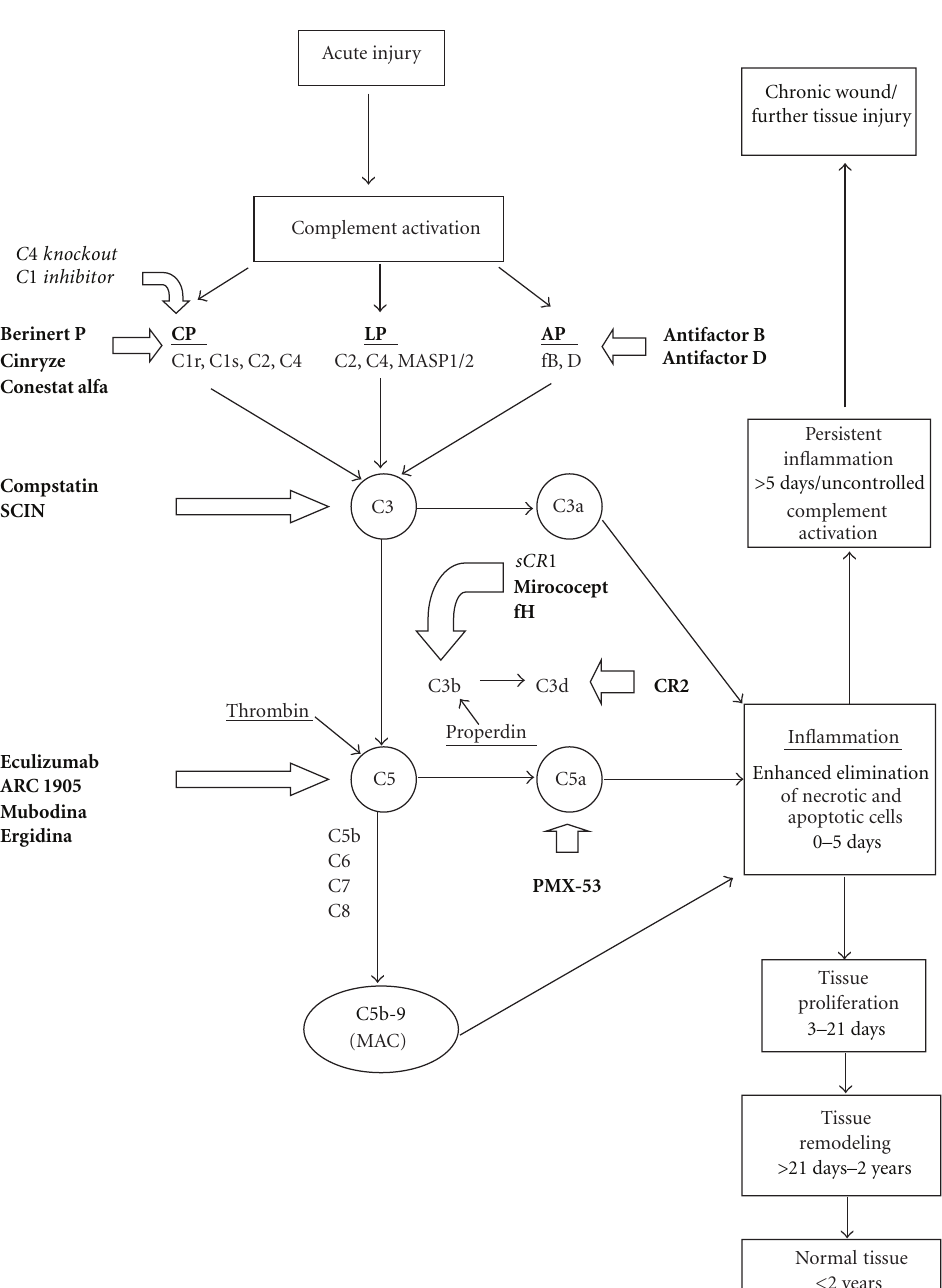
Figure 1: A simplified overview of the complement activation cascade after injury leading to wound healing. Three major pathways of complement activation, that is, the classical pathway (CP), the alternative pathway (LP), and the lectin pathway (LP), and two minor pathways initiated by properdin and thrombin are known. C is a complement component, MASP is mannan-binding serine peptidase, fB and D are factors B and D, SCIN is staphylococcal complement inhibitor, sCR1 is soluble complement receptor 1, fH is factor H, CR2 is complement receptor 2 and MAC is membrane attack complex. For simplicity, not all of the natural regulators of complement activation are shown in this diagram. The (pre)clinical complement inhibitors are denoted in bold and the complement factors that have been investigated in burn wound models in italic. C1 inhibitor a ff ects C1r, C1s from the CP, and MASP 1 and MASP 2 from the LP. C4 knockout also a ff ects both CP and